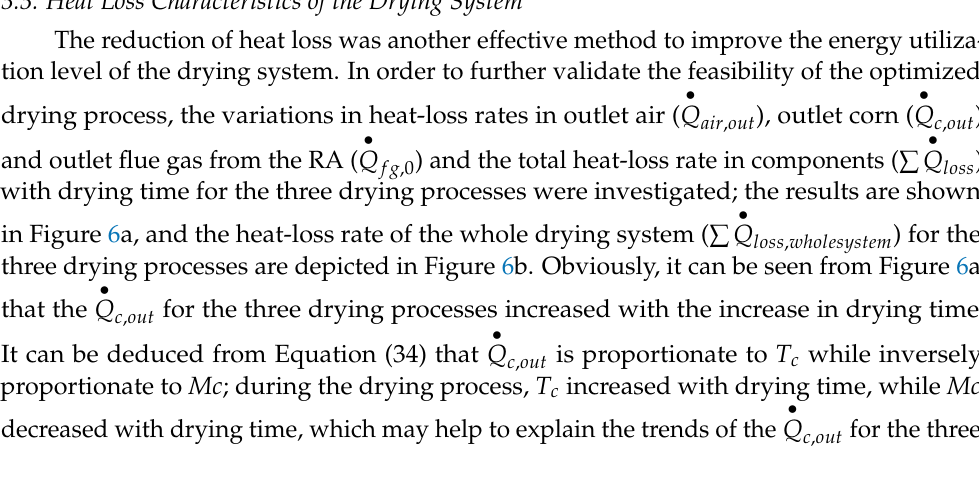
Figure 4. Comparison of the drying performance under different processes.